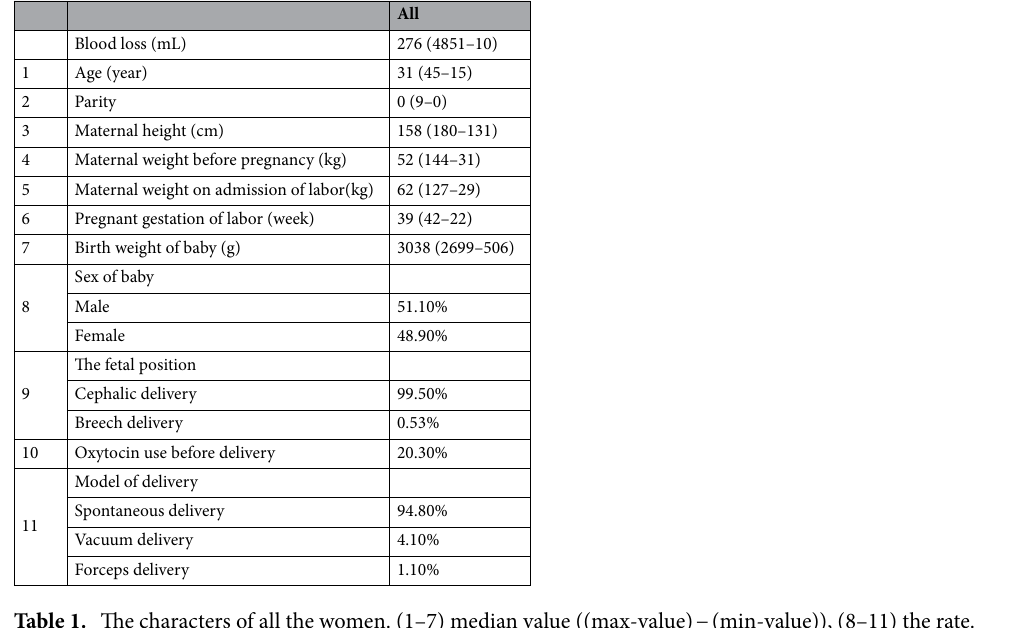
Table 1. The characters of all the women. (1–7) median value ((max-value) − (min-value)), (8–11) the